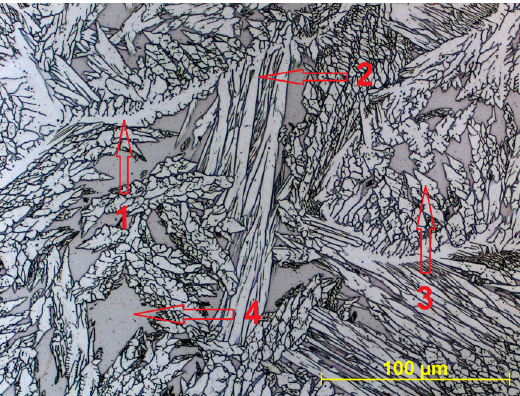
Figure 3. Microstructure of the FZ with the AWS ER2209 electrode using 4 KJ / cm. Highlight for points (1)